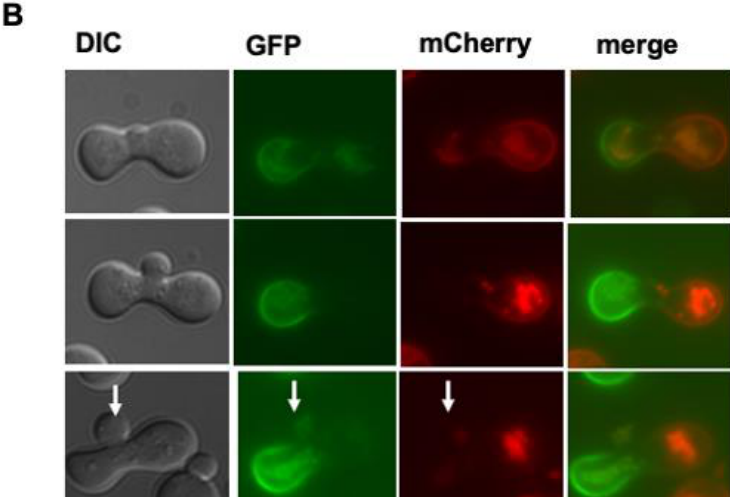
FIGURE 3: Up-regulation of Osh6 delays the secretion of Pma1. (A) Comparison of the locali- zation of Pma1-mCherry in wild type (QAY559) and P ERG6 - OSH6 (FTY518). Cells were grown to early log phase and photographed. The arrow points to vacuole-like structures of intracellular Pma1. The arrowhead points to a bud without normal Pma1 on the PM. (B) . Zygote assay. A MATα strain of Pma1 -GFP in wild type (HHY103) was mated with a MATa strain of Pma1-mCherry in P ERG6 - OSH6 (FTY517) and the resulting zygotes were photographed. Zygotes with different sizes of buds were presented from the top row (small- est bud) to the bottom row (largest bud). Arrows point to